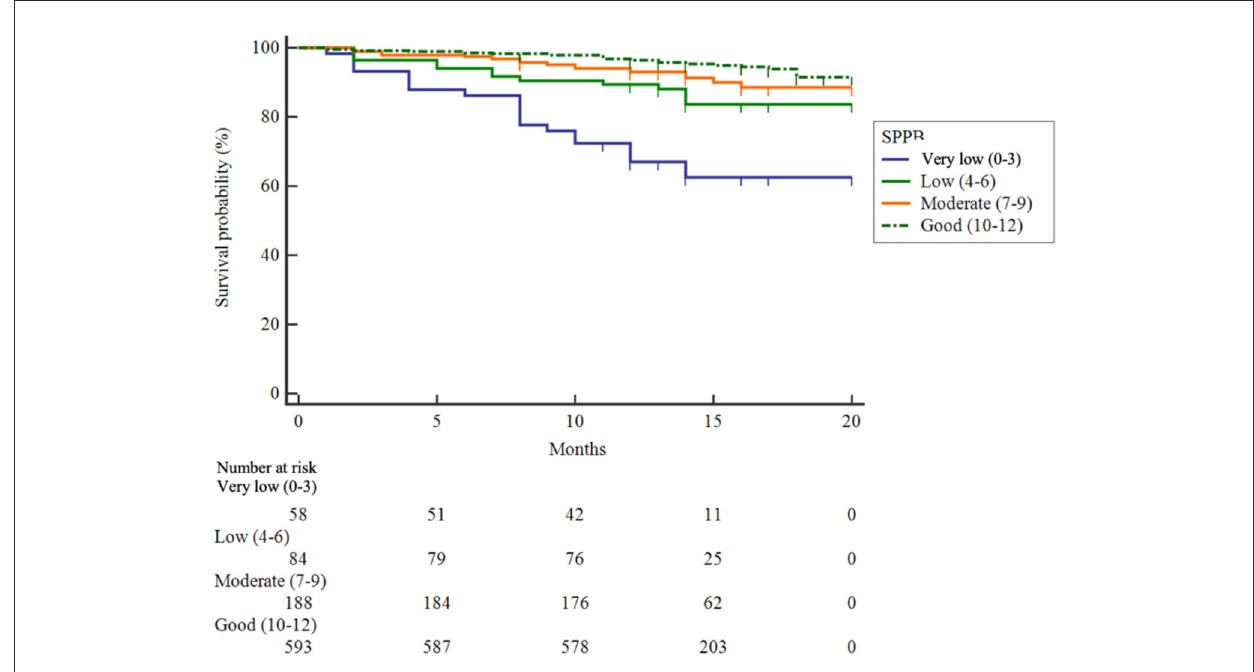
FIGURE2 Kaplan Meier survival curves for all-cause mortality according to SPPB.